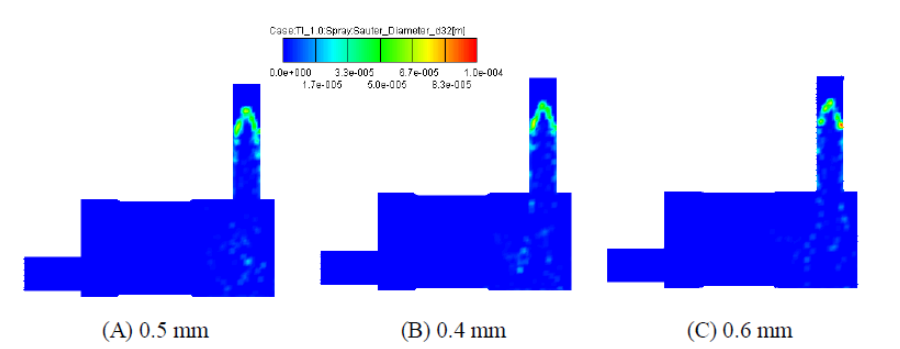
Fig. 11 Particle distribution with different nozzle diameters (Y cross section).